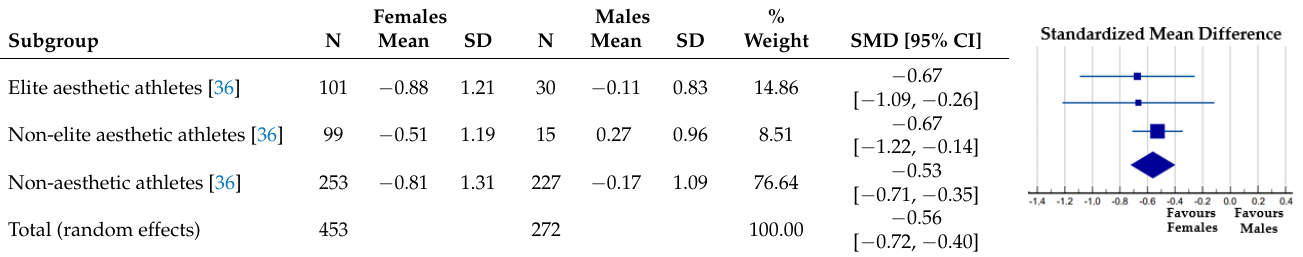
Table 2. BID by gender: results of the meta-analysis.